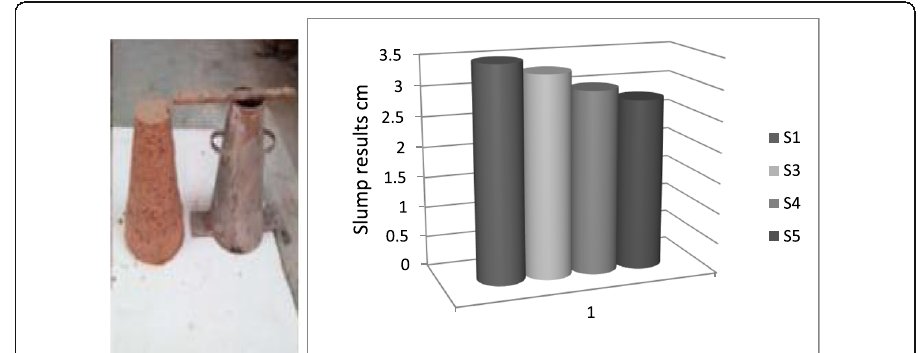
Fig. 2 Relationship between slump of GPCs and addition ratio of